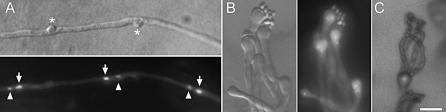
αADα Hybrids Mate as α Cells(A) Hyphae produced by mating between the natural αADα hybrid 6–20 and JEC20 reference strain on V8 medium were fixed and stained with DAPI. Diploid nuclei (arrows) are brighter and larger than their haploid counterparts (arrowheads) when stained with DNA fluorescent dyes [73,97]. Dikaryotic mating hyphae containing two nuclei per compartment, which alternate position at each conjugate division, were observed during mating. Fused clamp cells are indicated by asterisks in the DIC image.(B) Basidia at different stages of development.(C) Four long spore chains produced on the surface of a basidium during mating.Scale bar, 10 μm.